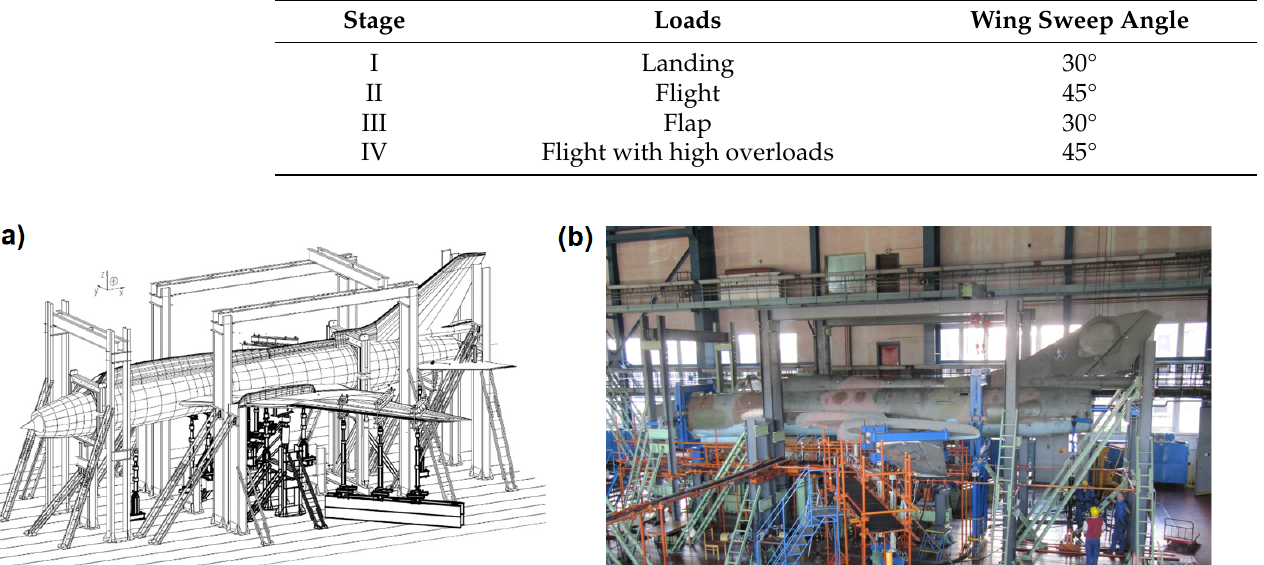
Figure 1. Full-Scale Fatigue Test rig: ( a ) schematic view and ( b ) actual